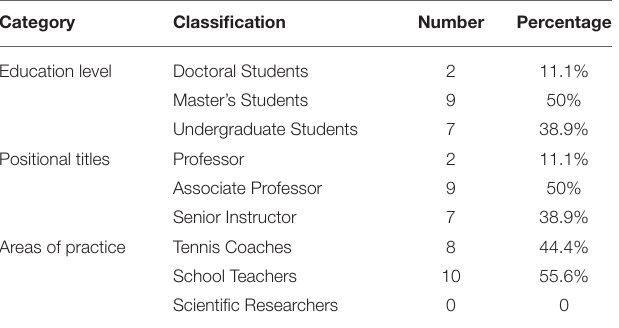
TABLE 1 | The basic information of the investigation experts.